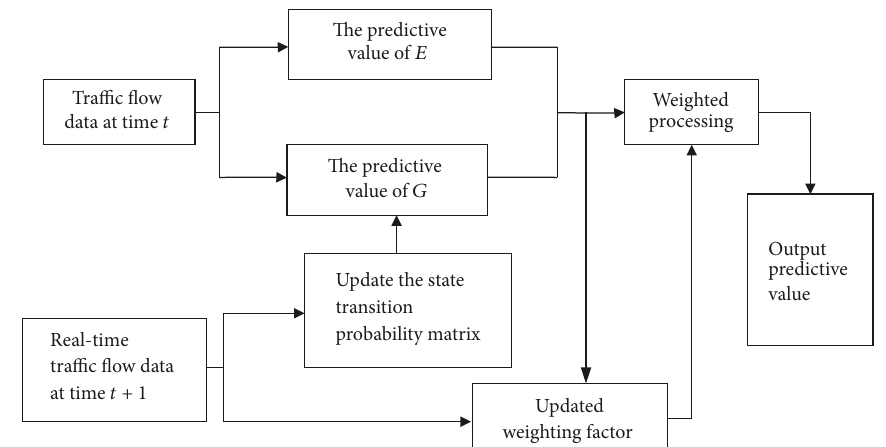
Figure 2: Grey difference exponential smoothing forecasting